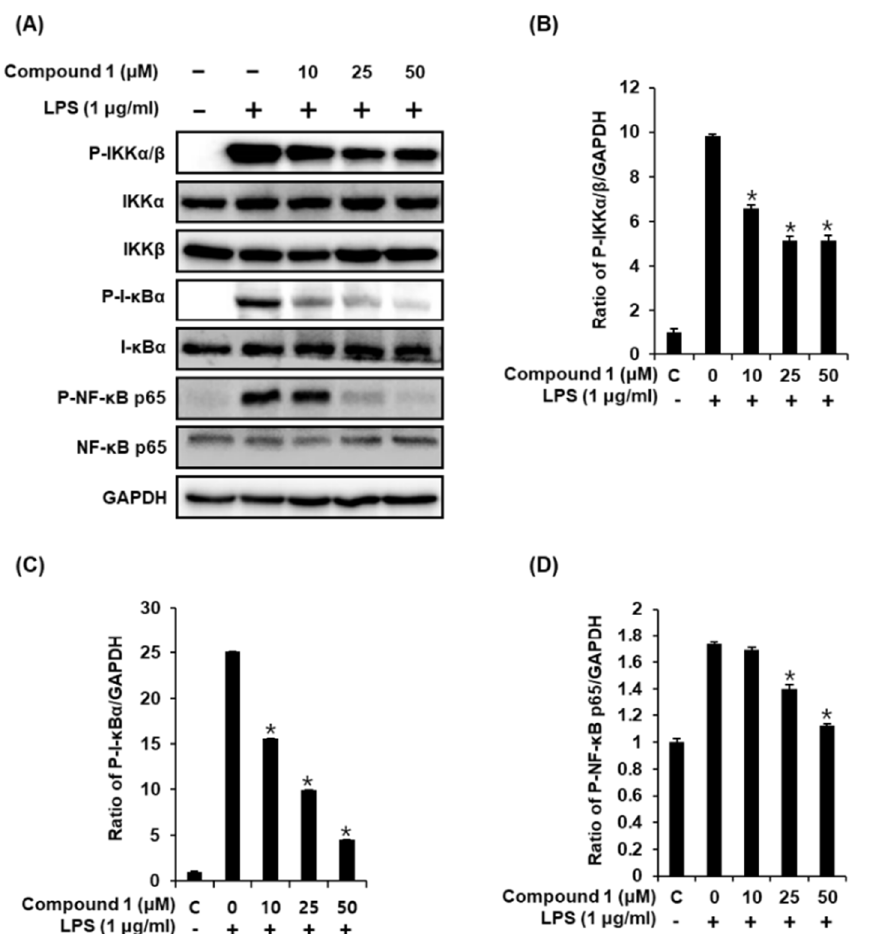
Figure 5. Effects of compound 1 on the LPS-induced expression of IKK α / β , I- κ B α , and NF- κ B p65 proteins in RAW 264.7 mouse macrophages. ( A ) Representative western blots for IKK α / β , I- κ B α , NF- κ B p65, and GAPDH protein expression. ( B ) Quantitative graph for P-IKK α / β . ( C ) Quantitative graph for P-I- κ B α . ( D ) Quantitative graph for P-NF- κ B p65 (mean ± SD, * p < 0.05 as compared with the LPS-treated group).